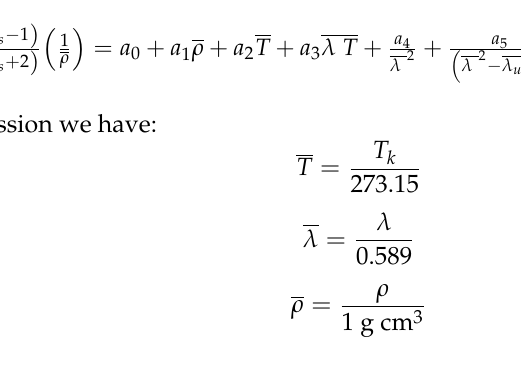
Table A1. Coefficients of the water index of refraction Formula